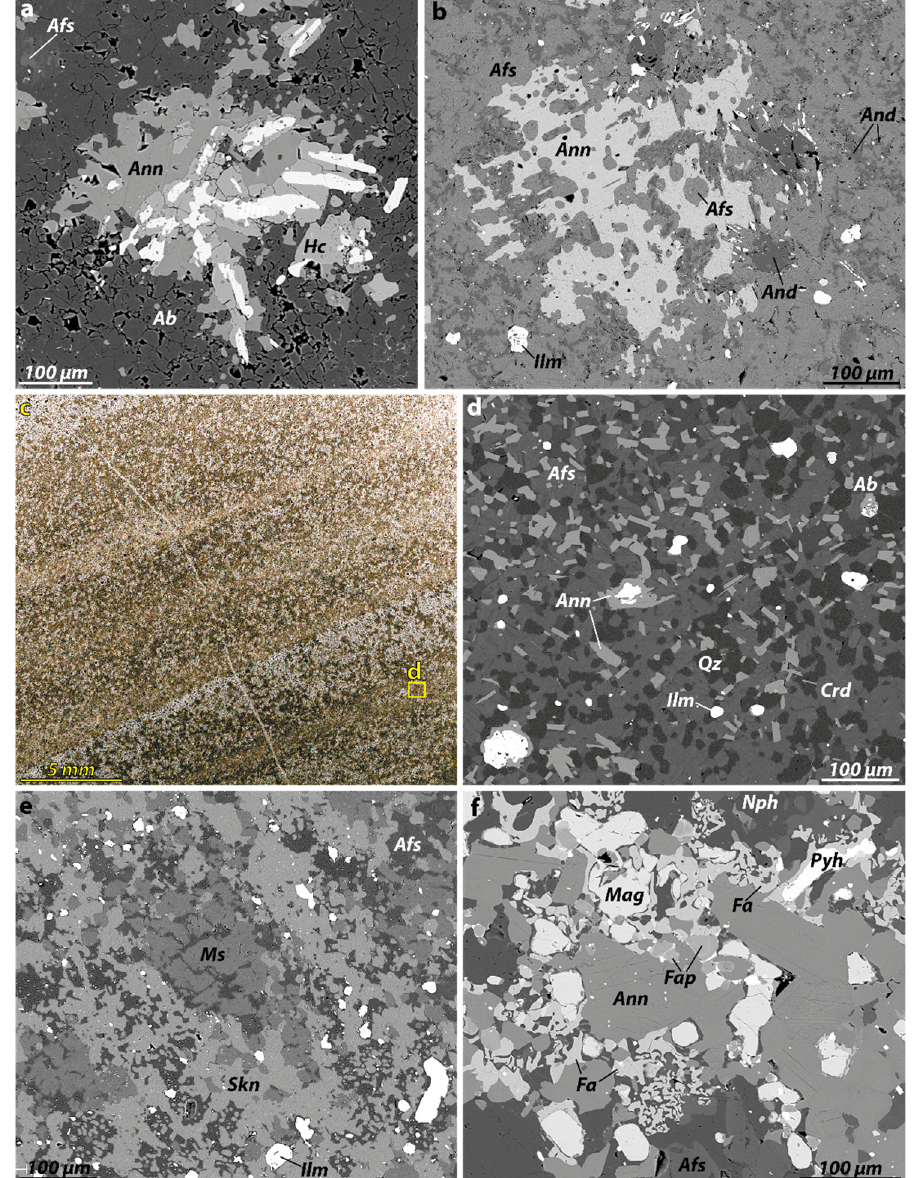
Figure 9. Mineral associations of hornfelses. ( a ) plate annite crystals and fine albite grains surround ilmenite and hercynite grains (sample LV-119); ( b ) poikilitic annite crystal with inclusions of (K,Na)- feldspar and andalusite (sample KCH-05-15); ( c ) hornfels with banded texture where light-colored layers enriched in quartz, and dark-colored ones enriched in annite and cordierite (sample LV-01-45); ( d ) detailed image of Figure 9d; annite replaces ilmenite and titaniferous magnetite; ( e ) hornfels consisting of sekaninaite, muscovite and alkali feldspar (sample E-97-5); ( f ) fayalite in association with annite, titaniferous magnetite and fluorapatite (sample E-97-41). Photo of polish section in transmitted light ( c ) and BSE-images ( a , b , d – f ).